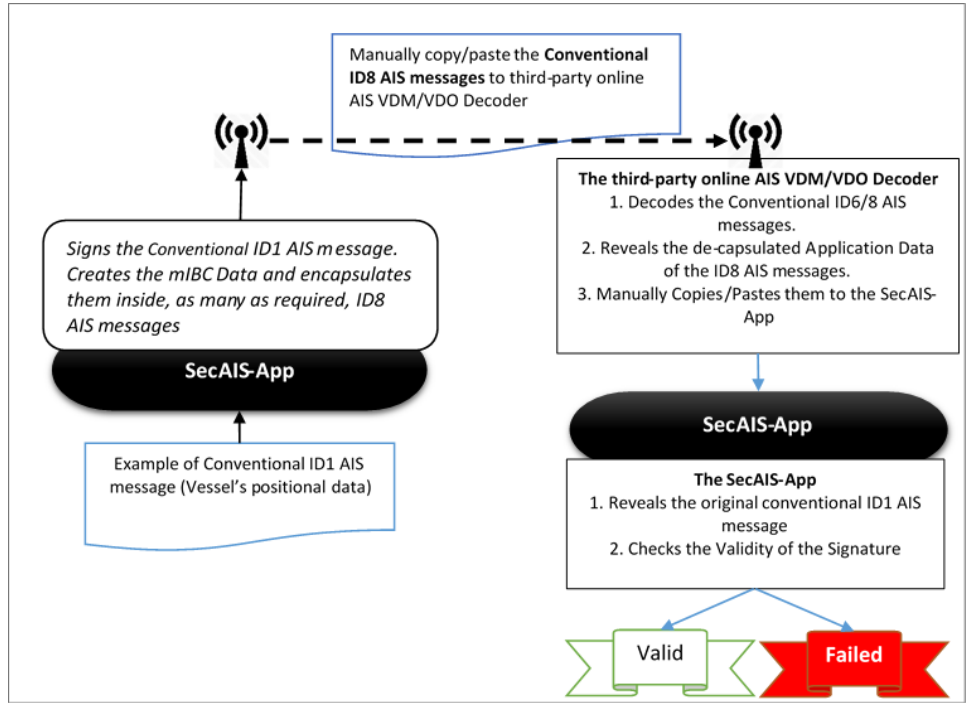
Figure 2. Simulated operation of the Authenticated SecAIS (mode 2) using ECSSI